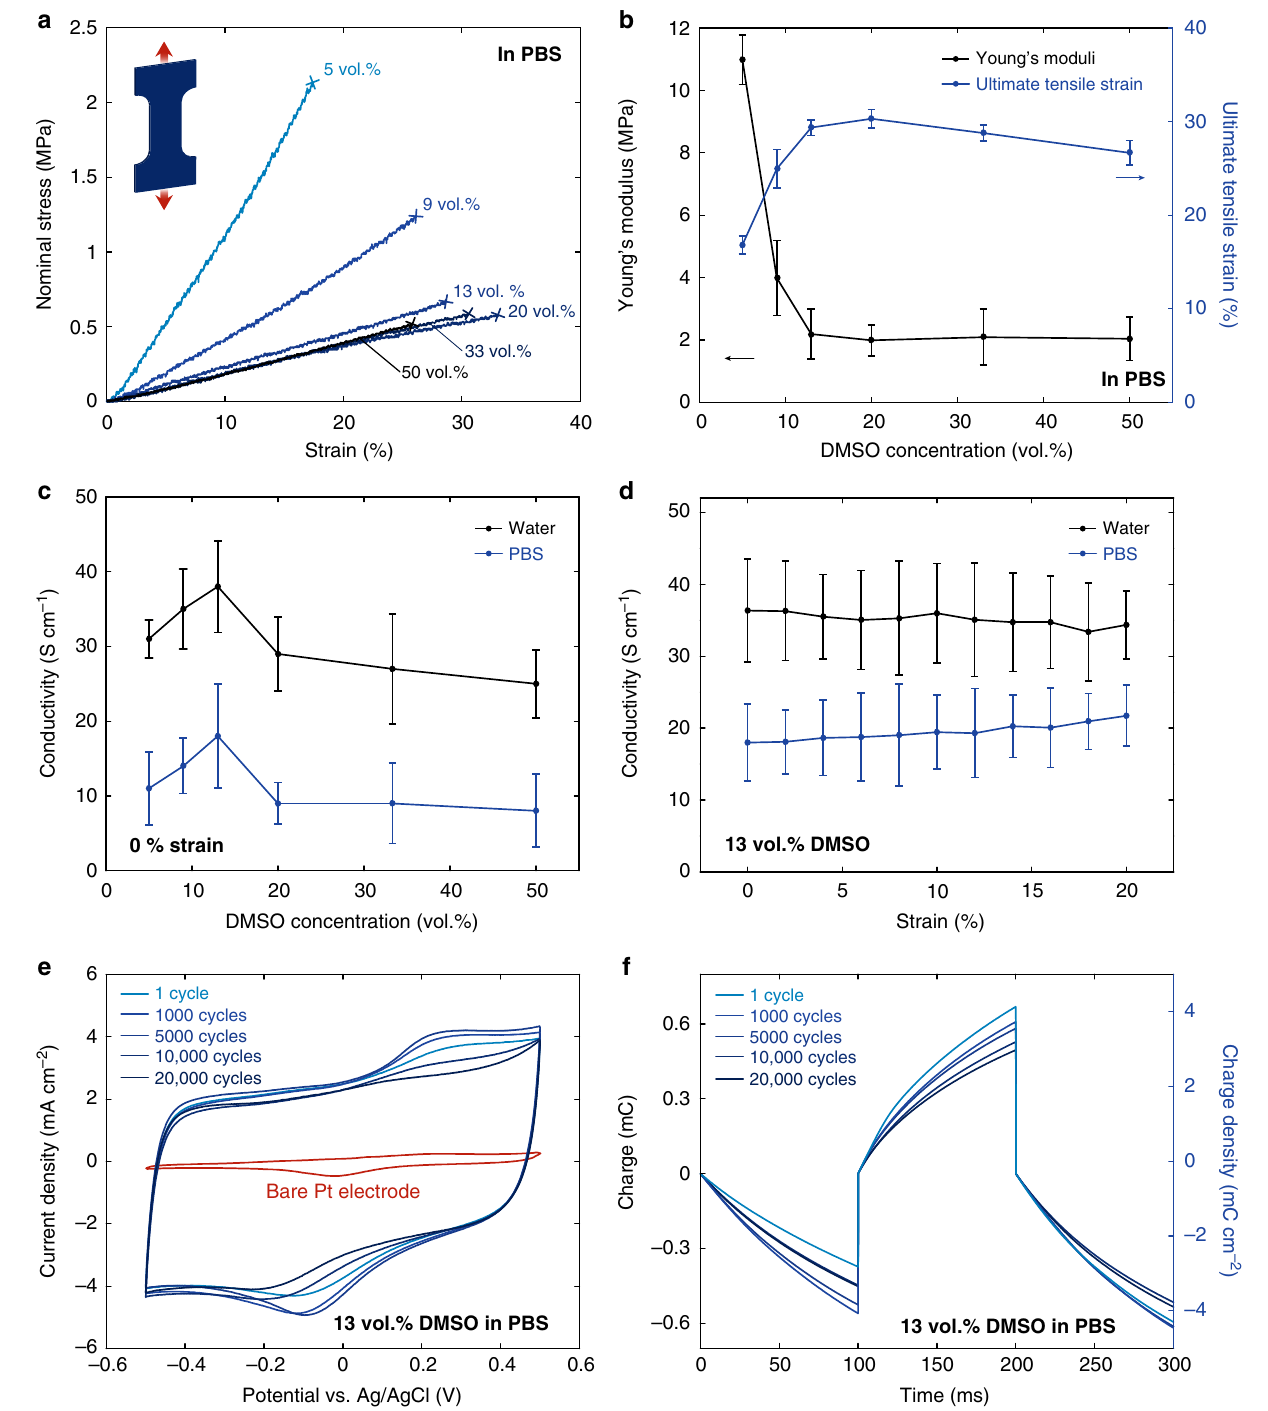
Fig. 4 Mechanical and electrical characterizations of pure PEDOT:PSS hydrogels. a Nominal stress vs. strain curves of free-standing pure PEDOT:PSS hydrogels in PBS with varying DMSO concentrations. b Young ’ s moduli and ultimate tensile strains vs. DMSO concentration for pure PEDOT:PSS hydrogels in PBS. c Electrical conductivity of pure PEDOT:PSS hydrogels both in deionized water and in PBS with varying DMSO concentrations. d Electrical conductivity of pure PEDOT:PSS hydrogels at different strain both in deionized water and in PBS. e CV curves for the pure PEDOT:PSS hydrogel on Pt electrode in PBS. Red curve represents the CV curve of bare Pt electrode as a control. f Cyclic electrochemical current pulse injection curves of the pure PEDOT:PSS hydrogel on Pt electrode under between − 1.5 V and 1.5 V vs. Ag/AgCl. Values in b – d represent mean and the error bars represent the SD of the measured values ( n =